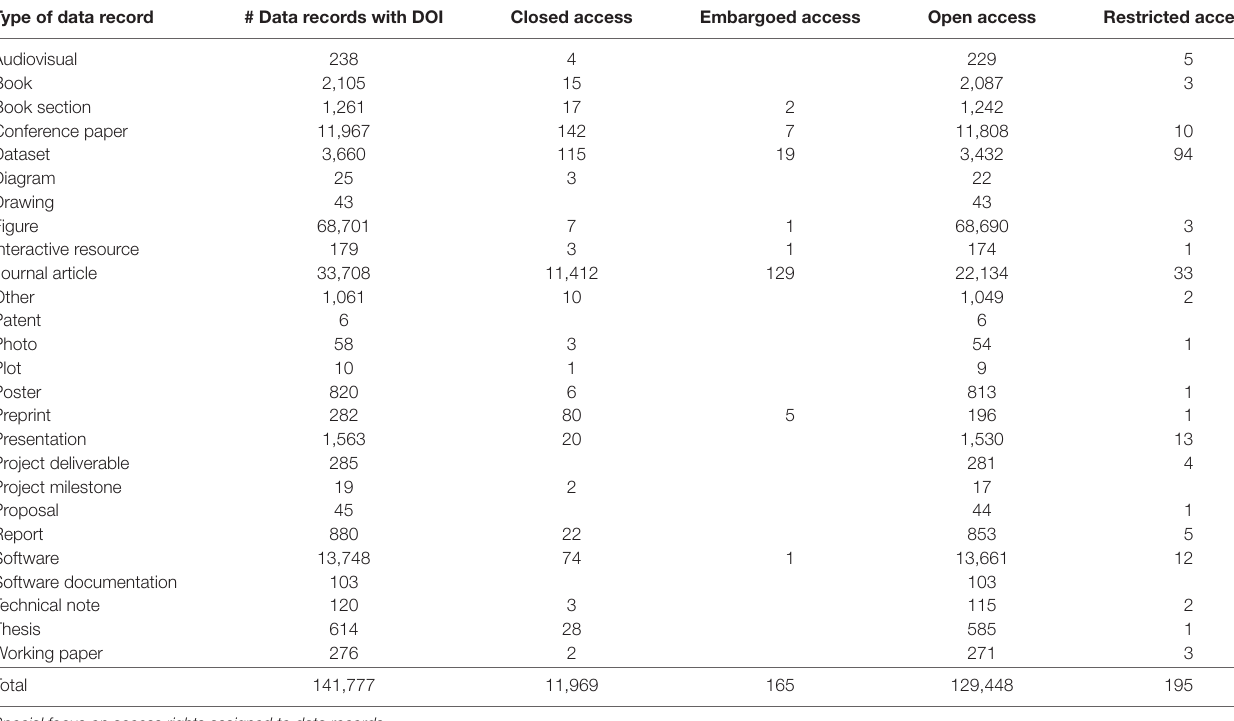
Table 1 | Description of Zenodo data records with digital object identifier (DOI) and all publication